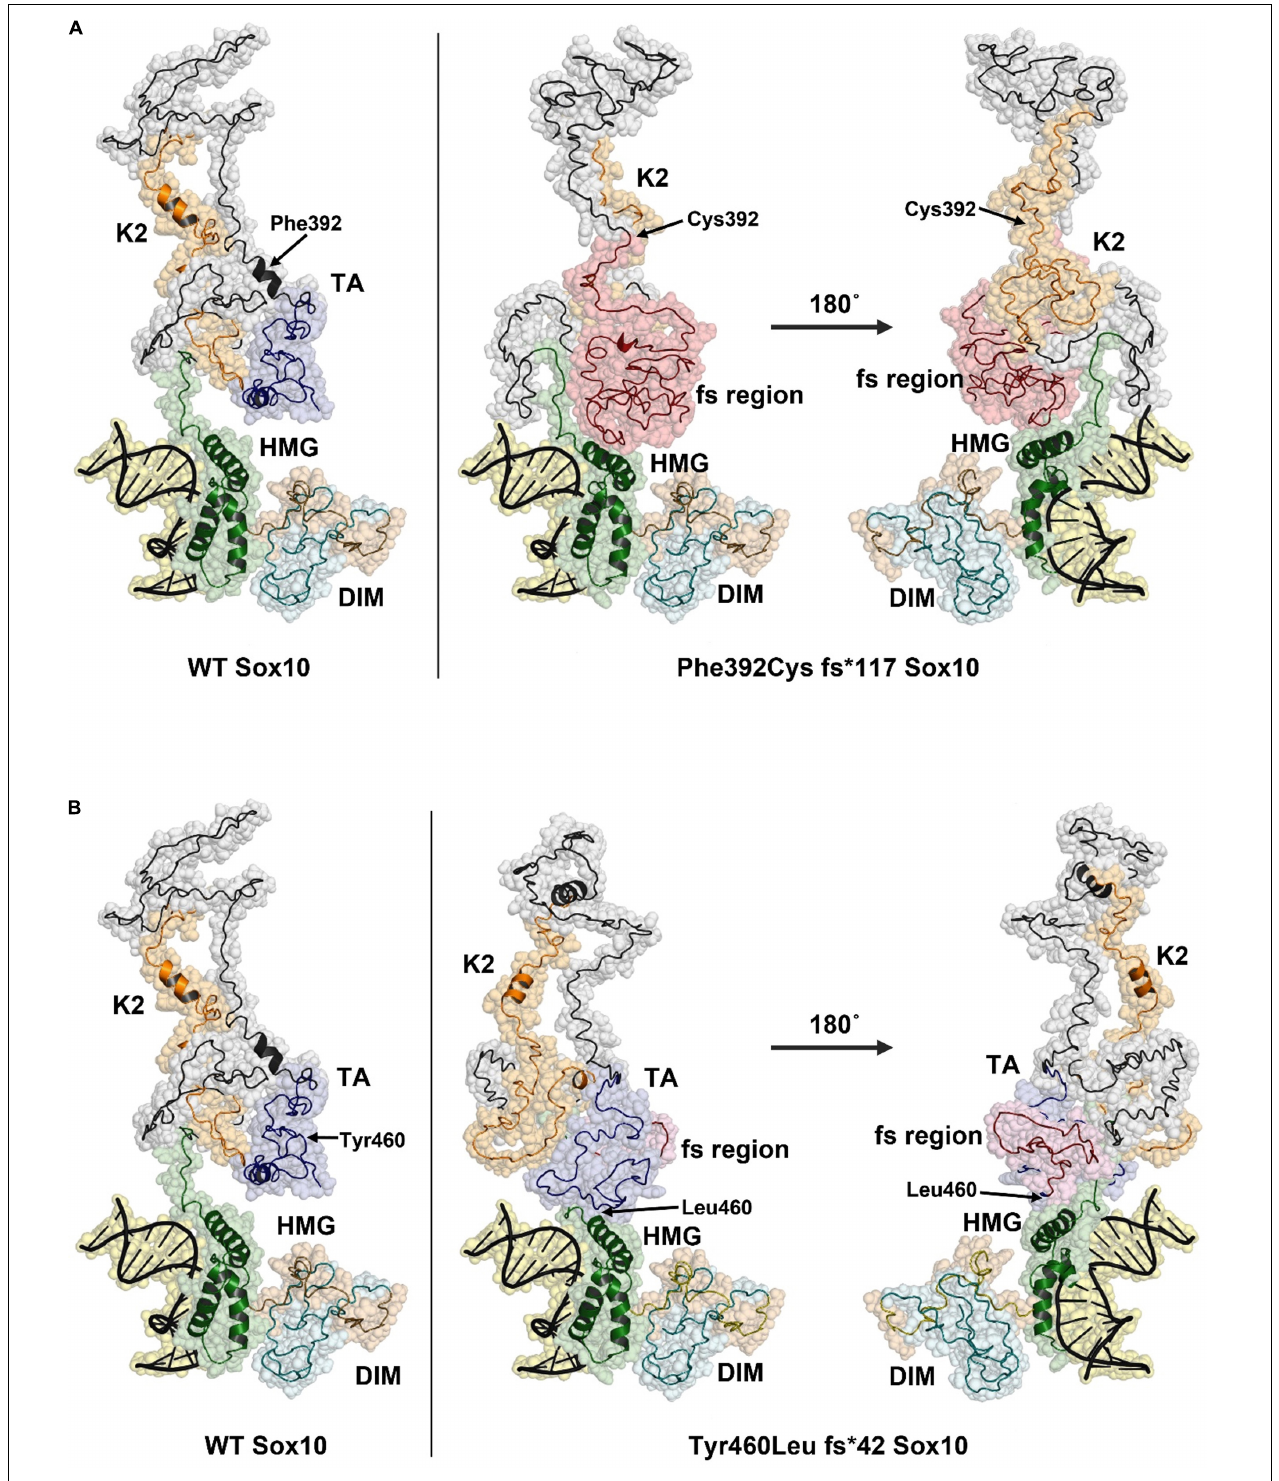
FIGURE 5 | Structural models of Phe392Cysfs*117 and Tyr460Leufs*42 SOX10 frame-shift (fs) variants. The position of Phe392 and Tyr460 are indicated with arrows in the WT structure model (left panel). The positions of substituted residues are indicated with arrows in the mutant structures. Amino acid residues that result from the frame shift mutation are shown in red. (A) Model of Phe392Cys fs*117 Sox10, the HMG domain is compacted due to the presence of the fs region and may impact DNA binding. (B) The Tyr460Leu fs*42 model predicts a change in the TA structure with additional contacts between the TA/fs region and the HMG domain. This structural change may reduce activity of the TA